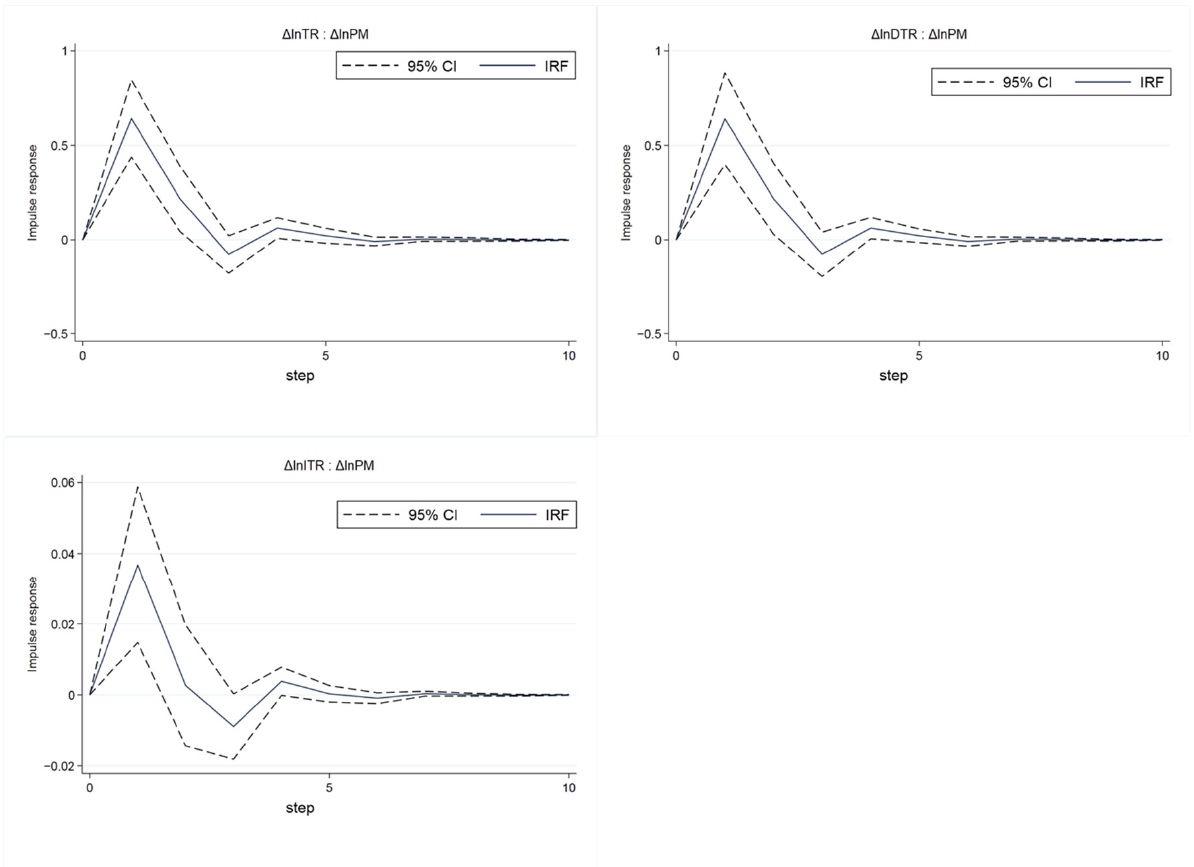
Figure 4. The results of impulse response with total/domestic/inbound tourism revenue as variable.